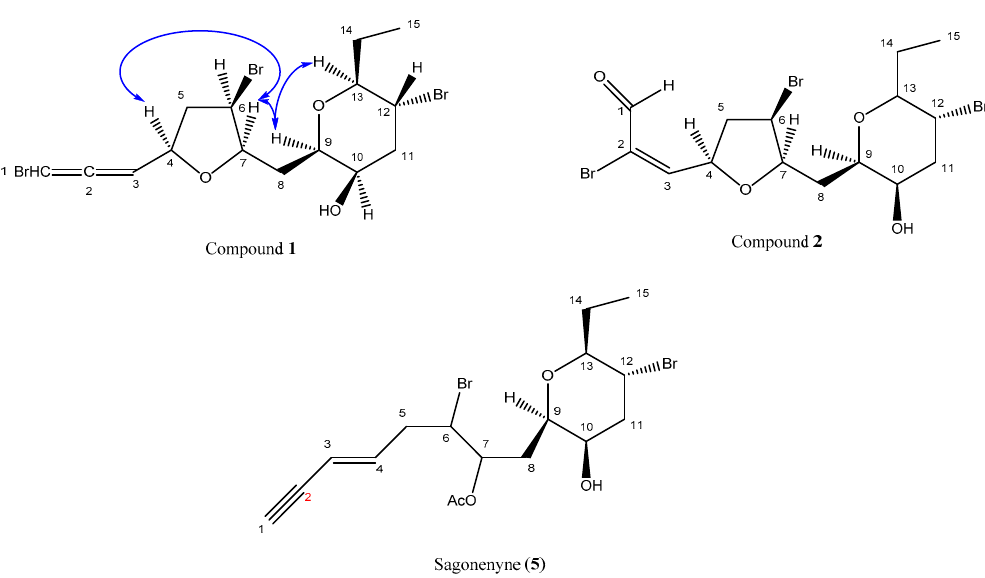
Figure 1. Structures of compounds 1 , 2, and sagonenyne ( 5 ). Key NOESY correlations of compound 1 are represented by blue arrows. Table 1. NMR spectroscopic data (400 MHz, CDCl 3 ) of compounds 1 and 2